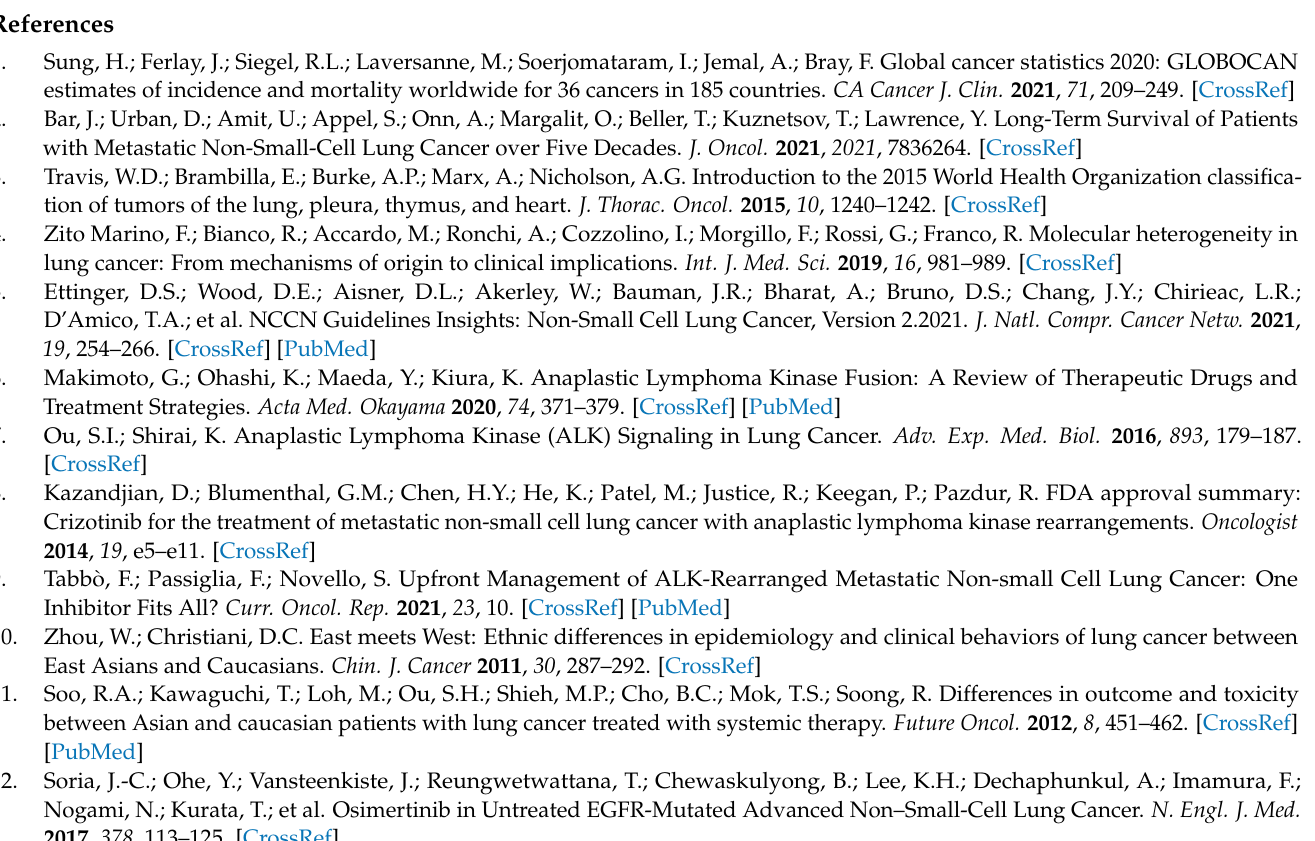
Figure A 7. Probability of being the best treatment with regard to objective response rate (ORR).